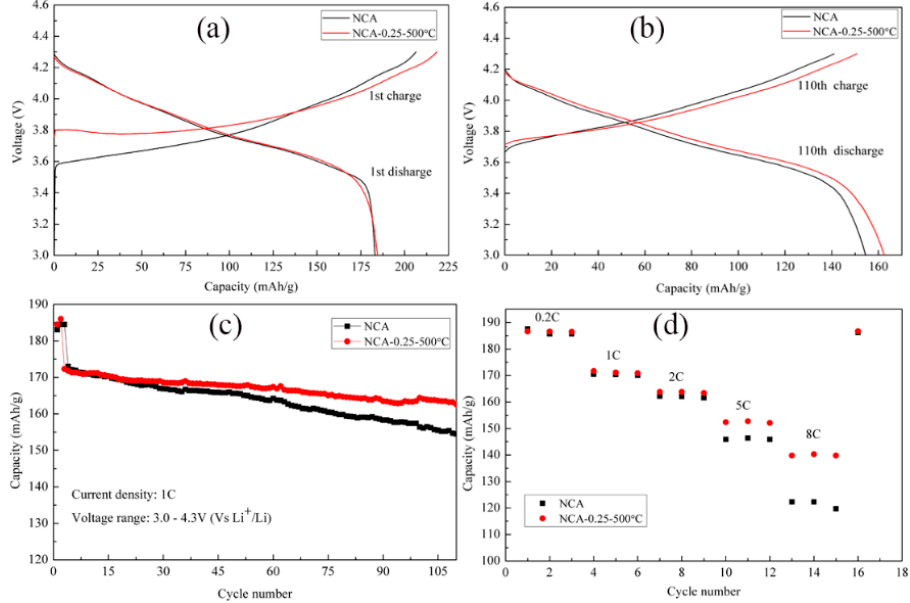
Figure 6. Charge and discharge profiles at the first cycle at 0.2 C ( a ) and at the 110th cycle at 1 C ( b ) of the as-prepared samples; the cycle performances at 1 C ( c ) and rate capability ( d ) of the as-prepared samples.